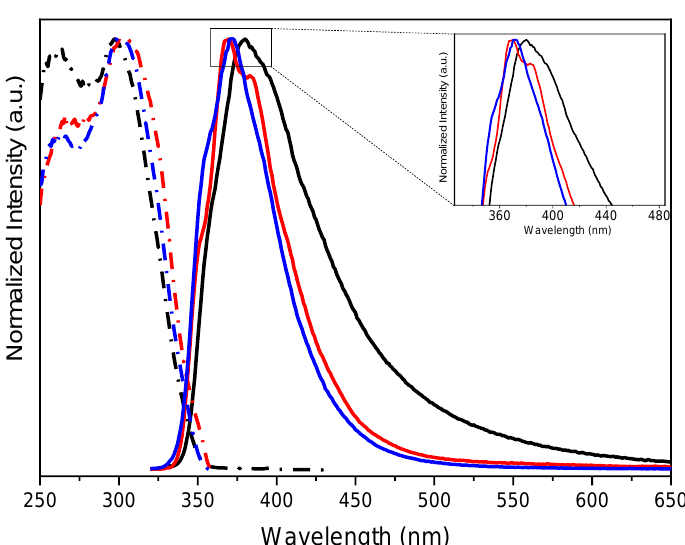
Figure 4. Normalized PL emission (continuous lines) and excitation (dashed – dotted lines) spectra of ground crystals of TT-HThio : ( a ) 298 K, emission at  exc = 300 nm (black), 376 nm (blue), 450 nm (red), excitation at  em = 365 nm (black), 434 nm (blue), 597 nm (red); ( b ) 77 K, emission at  exc = 300 nm (black), 376 nm (blue), 440 nm (red), excitation at  em = 375 nm (black), 443 nm (blue), 513 nm (red). In diluted DCM solutions (1 × 10 − 5 M), TT-(HThio) 3 displays a single fluorescence (FL,  = 5%, λ em = 380 nm,  = 1.17 ns at 298 K and λ em = 370 nm, 1.42 ns at 77 K, Figures 5, (FL, Φ = 5%, λ em = 380 nm, τ = 1.17 ns at 298 K and λ em = 370 nm, 1.42 ns at 77 K, Figures 5, S20, S2311). In PMMA-blended films (0.5 w% TT-(HThio) 3 ), one fluorescence (FL,  = S20, S21). In PMMA-blended films (0.5 w% TT-(HThio) 3 ), one fluorescence (FL, Φ = 17%, 17%, λ em = 372 nm,  = 0.90 ns at 298 K, Figures 5 and S28) is observed in exactly the same λ τ = 0.90 ns at 298 K, Figures 5 and S28) is observed in exactly the same em = 372 nm, position as that measured in DCM at 77 K. position as that measured in DCM at 77 K.